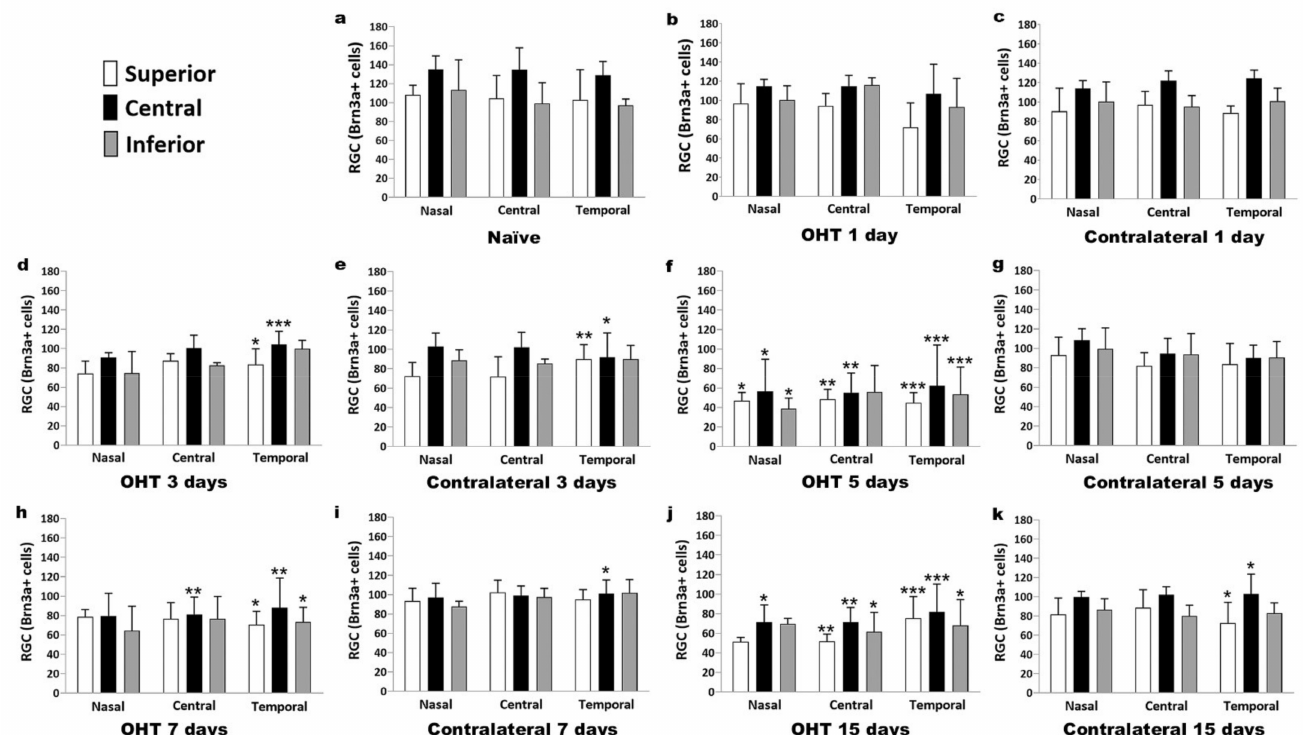
Figure 13. The variation over space and time in the number of Brn3a+ cells in the immunohistochemical assay. The histograms show the mean levels ( ± SD) of Brn3a+ cells at days 1, 3, 5, 7, and 15 after laser OHT induction. ( a ) Control naïve eyes; ( b , d , f , h , j ) ocular hypertension eyes (OHT); ( c , e , g , i , k ) contralateral eyes. In each region and zone of the retina: nasal-superior, nasal-central, nasal-inferior; central-superior, central-central, central-inferior; and temporal-superior, temporal-central, temporal-inferior. Statistical significance indicators: * p < 0.05, ** p < 0.01, *** p < 0.005, OHT vs. control naïve. Abbreviations: RGCs (retinal ganglion cells); Brn3a (brain-specific homeobox/POU domain protein 3A); OHT (ocular